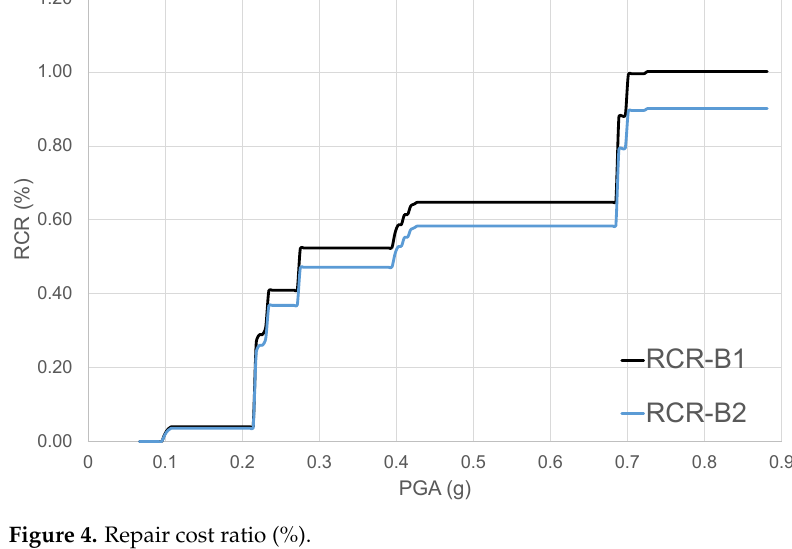
Figure 4. Repair cost ratio (%).